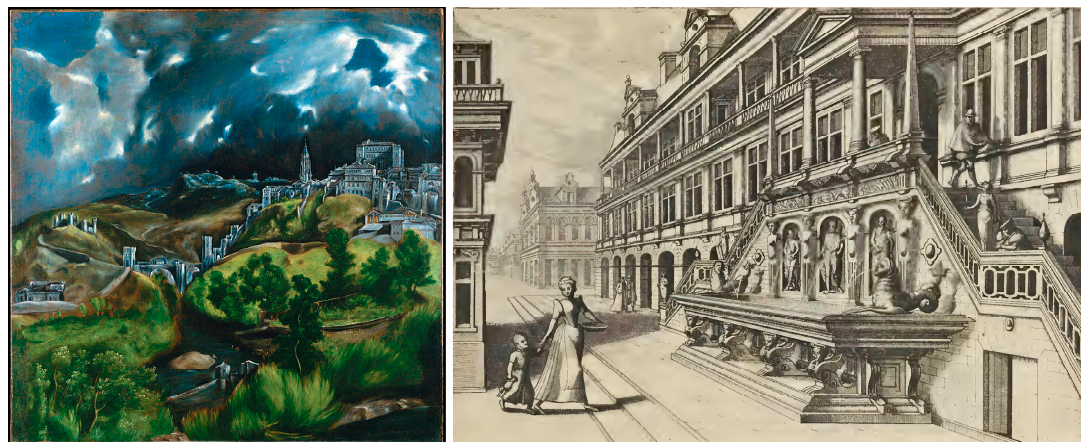
Figure 1. On the left , View of Toledo by El Greco [3]. On the right , reproduction of a plate of Hans Vredeman de Vries’s Artis perspectivae formulae , depicting a fountain in perspective [4].